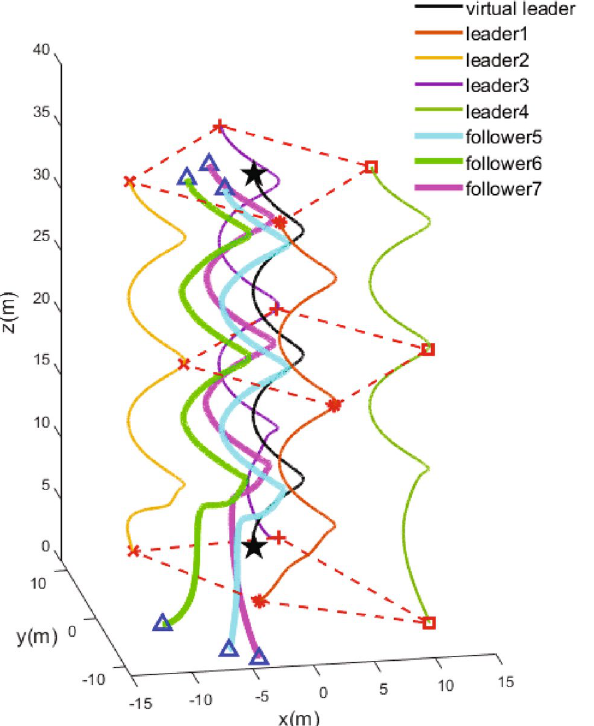
Figure 4. Three dimensional trajectory of